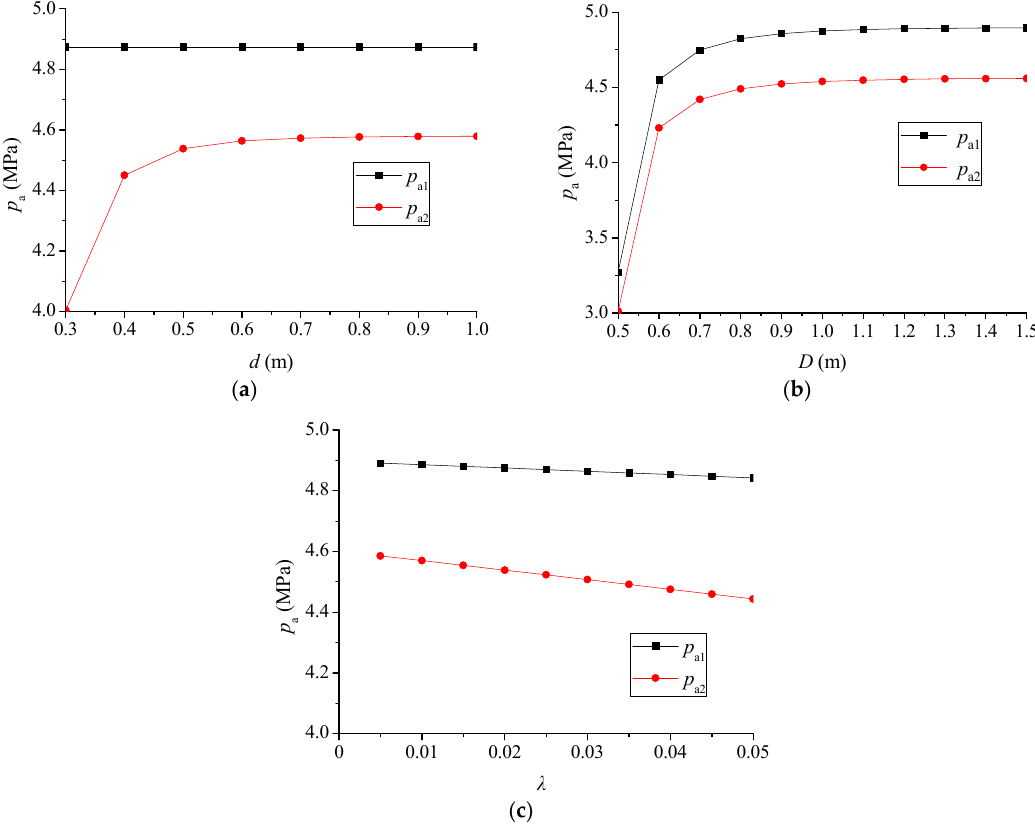
Figure 5. Variation of p a1 and p a2 with the parameters of the pipes. ( a ) diameter d varies while D = 1.0 m and 𝜆 = 0.02; ( b ) diameter D varies while d = 0.5 m and 𝜆 = 0.02; ( c ) friction coefficient 𝜆 varies while D = 1.0 m and d = 0.5 m.